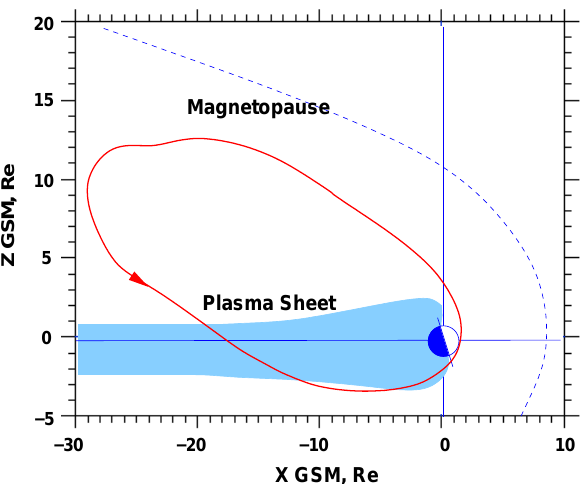
Fig. 1. An example of the Interball-1 (Tail Probe) orbit passing near the midnight meridional plane in winter season.